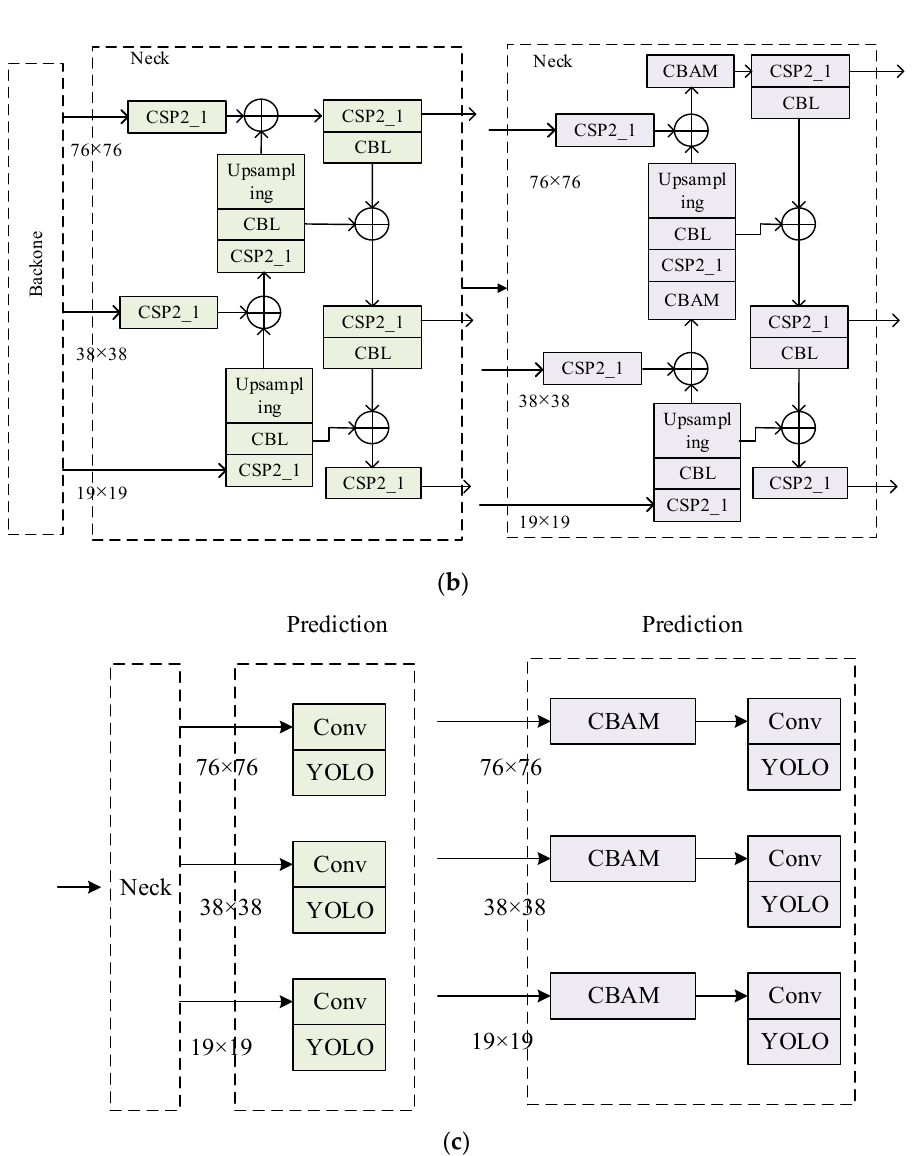
Figure 7. Network comparison before and after introducing CBMA attention mechanism. ( a ) CBAM